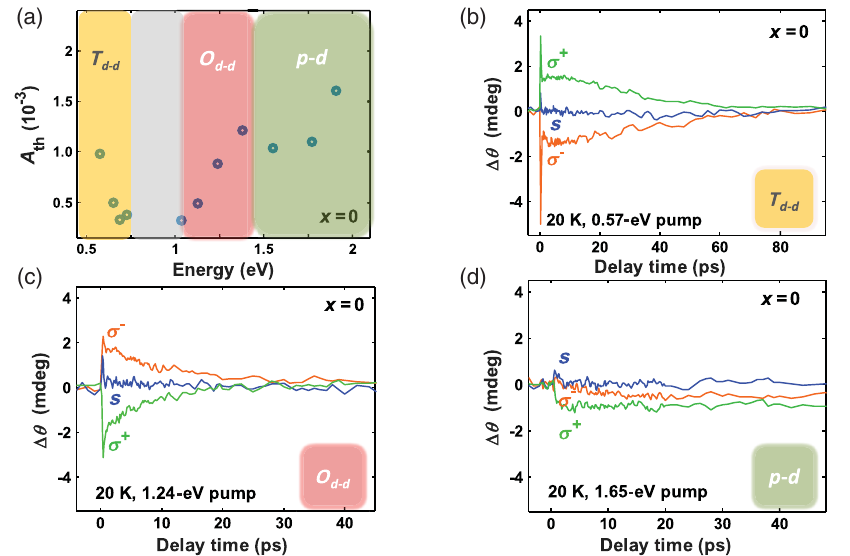
FIG. 3. (a) Absorption spectrum A as a function of photon energy at room temperature. (b) – (d) Time-resolved magneto-optical Kerr th effect (TRMOKE) measured at different excitation energies with various polarizations. TRMOKE displays two distinct characters for Þ around 0.5 – 0.6 eVand (c) d - d transition on O site ( O (b), d - d transition on the T site ð T ) near 1.1 – 1.5 eV. Both excitations show d - d d - d circularly polarized pump ( σ (cid:2) ) dependence, which disappears for p - d charge-transfer excitation ( p - d ) above 1.55 eV, with excitation at 1.65 eV displayed in (d). All the data shown here are measured from the x ¼ 0